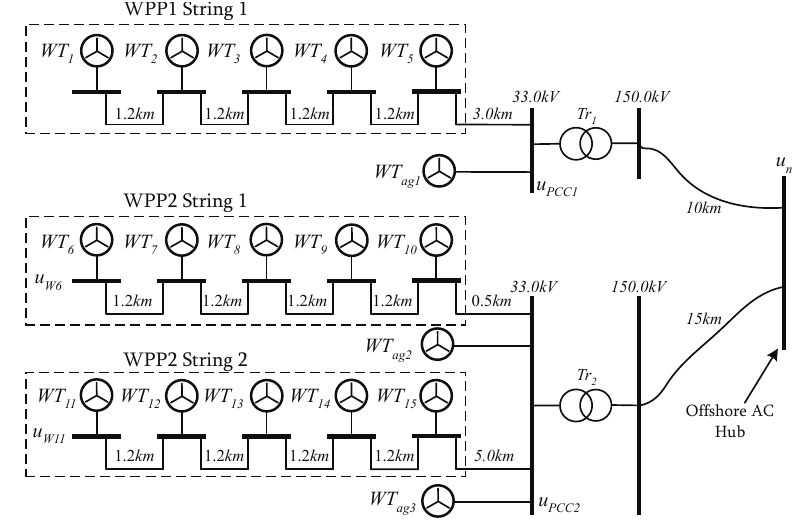
Figure 2. Offshore wind power plant layout and connection with the offshore AC hub.